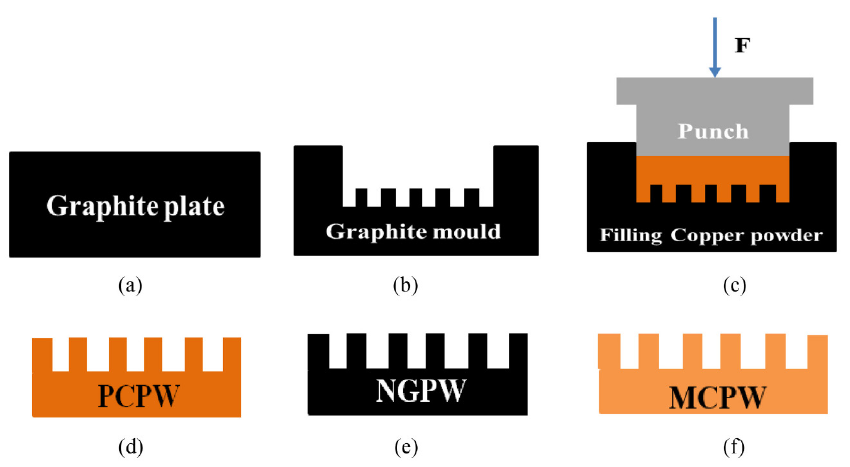
Figure 9. A schematic representation of the sample preparation processes form graphite plate to MCPW. ( a , b ) A micro grooved graphite mold is machined on a graphite plate by a computer numerical